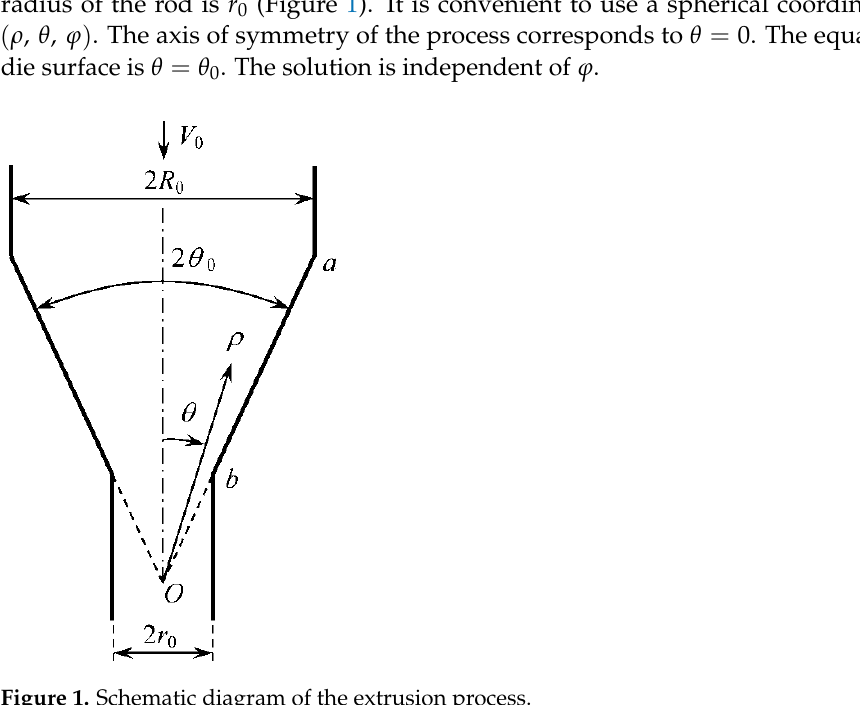
Figure 1. Schematic diagram of the extrusion process.